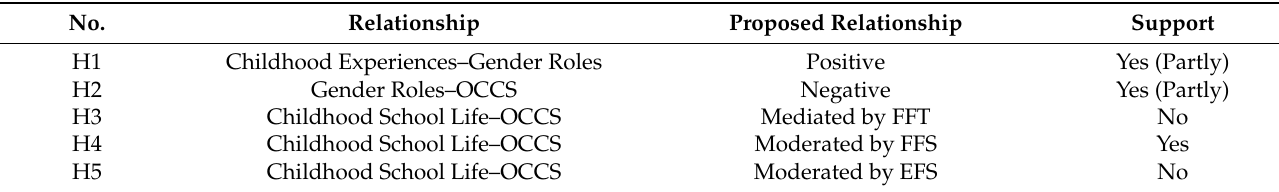
Table 5. Summary of Hypotheses Testing